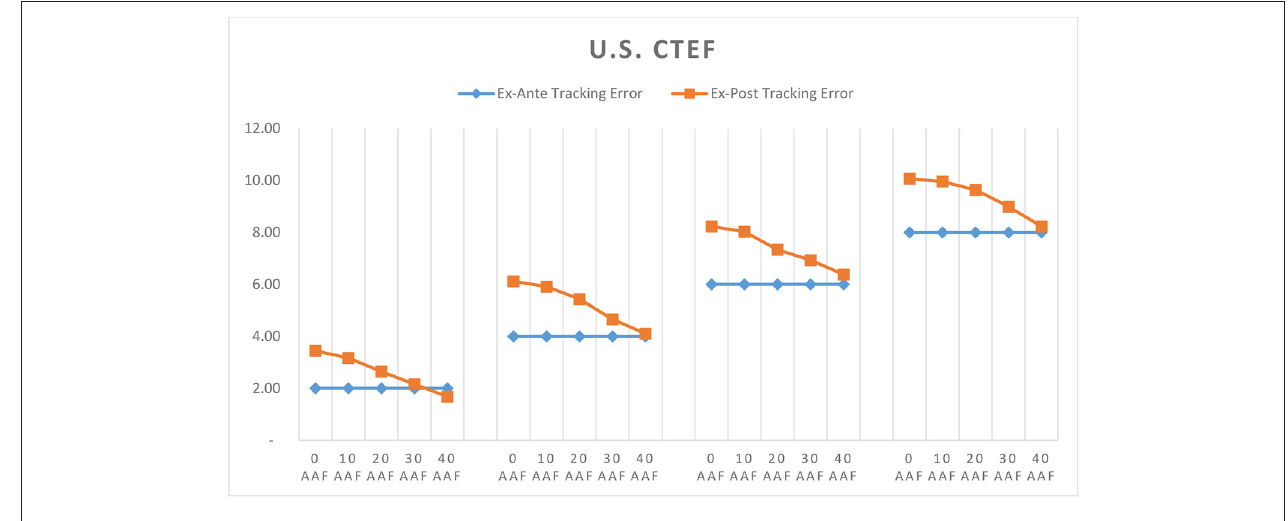
FIGURE 8 | U.S. CTEF ex-ante vs. ex-post tracking error.